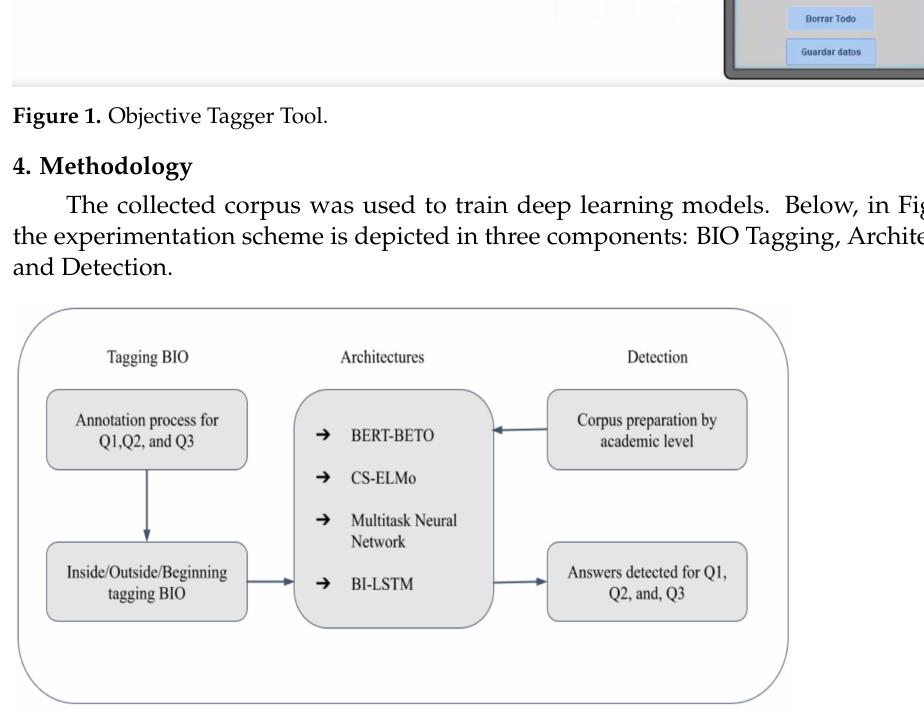
Figure 2. Experimentation